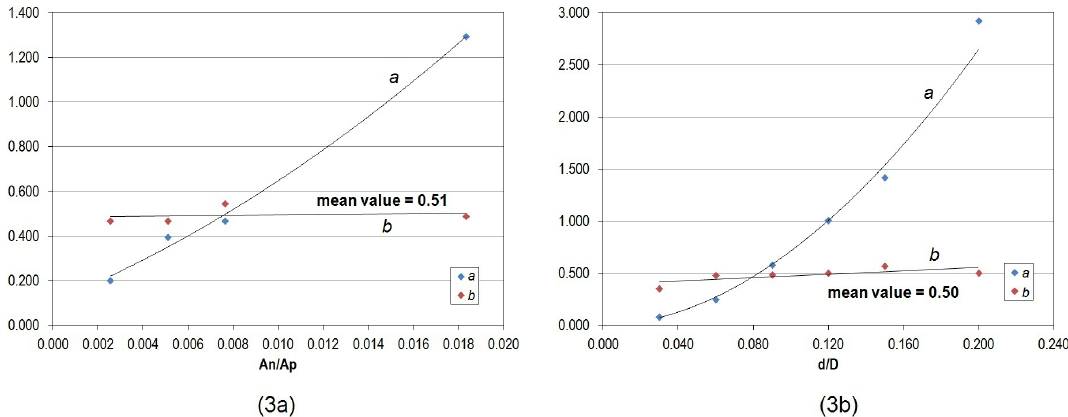
Figure 3. Discharge coe ffi cients according to: (a) surface ratio A n / A p (rectangular nozzles); (b) diameter ratio d / D (round nozzles). Static tests on steel pipe.